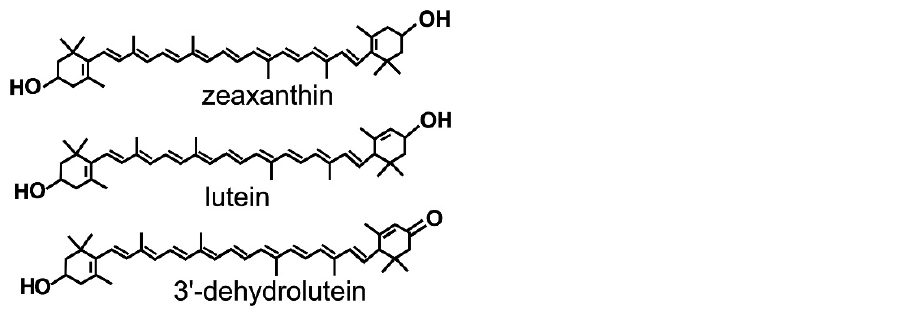
Figure 1. Structure of dietary carotenoids, zeaxanthin, and lutein, and their metabolite, dehydro-lutein.